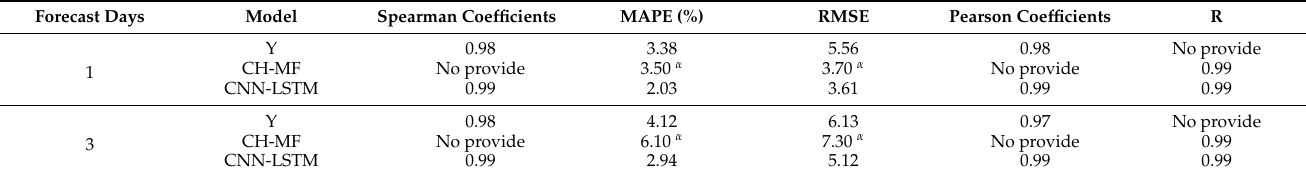
Table 3. Comparison between the observed and forecast values using the CH-MF and Y